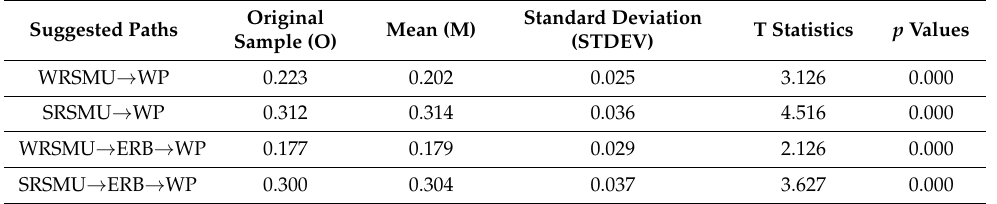
Table 5. Significance of path coefficient.